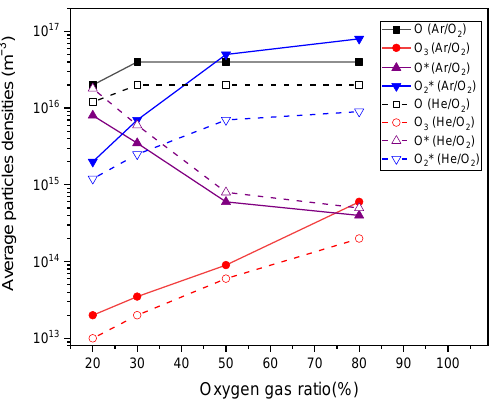
Figure 15. Average particles densities of Ar/O 2 and He/O 2 for different O 2 percentage at 0.3 Torr pressure and 13.56 MHz frequency. (*) Excited state of atoms.